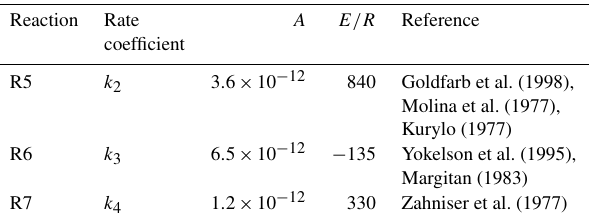
Table 3. Rate constants of bi-molecular gas-phase sinks of ClONO 2 . The Arrhenius factors A are given in units of cm 3 molecule − 1 s − 1 . The temperature dependence E/R (activation energy over universal gas constant) is given in units of kelvin. The values are taken from Burkholder et al.